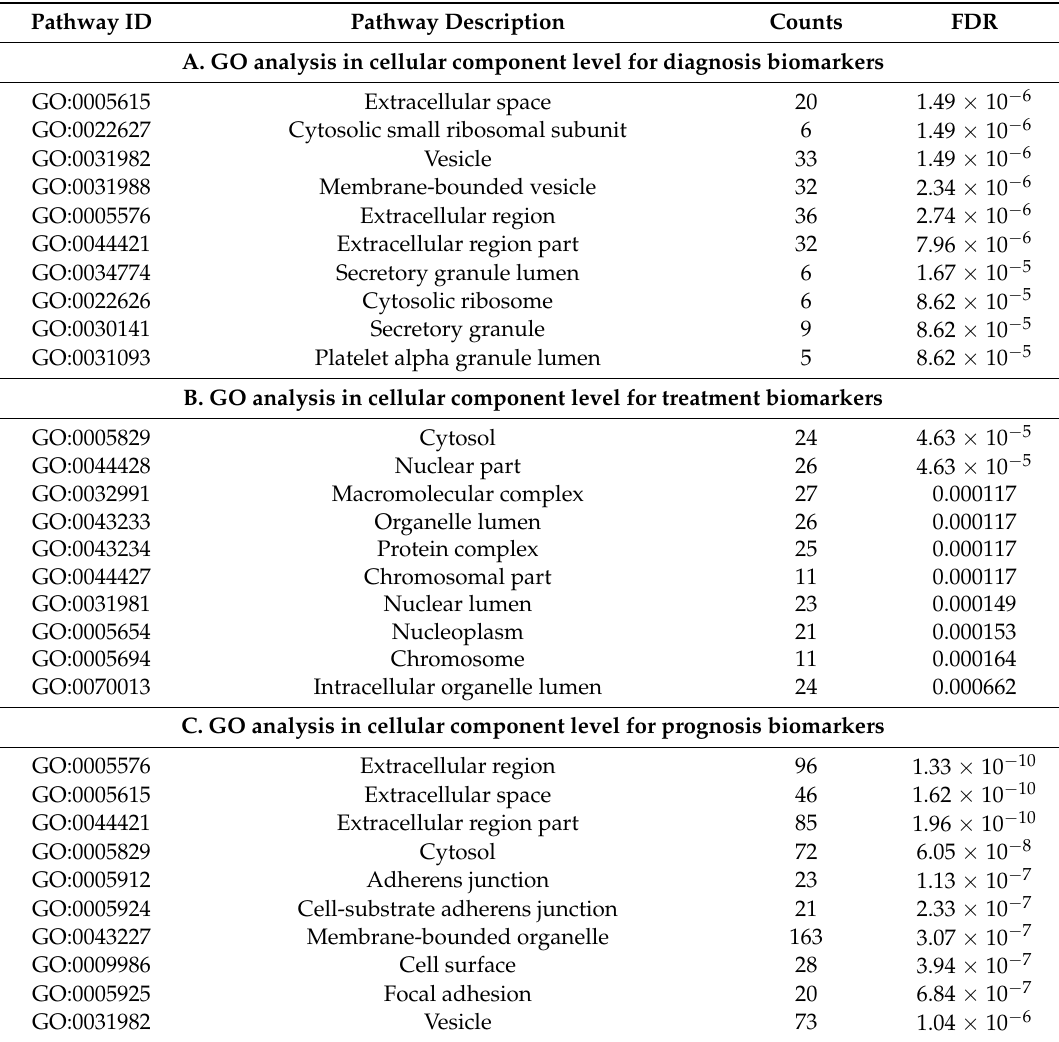
Table 4. GO analysis results in cellular component level for CRC protein